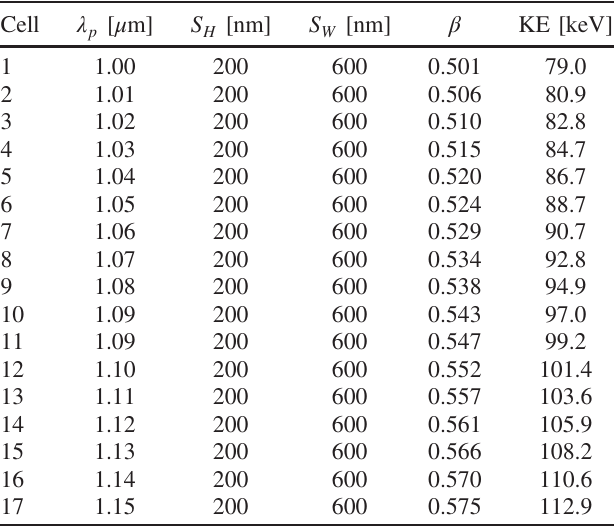
TABLE I. Optimized dimensions for a 17-cell